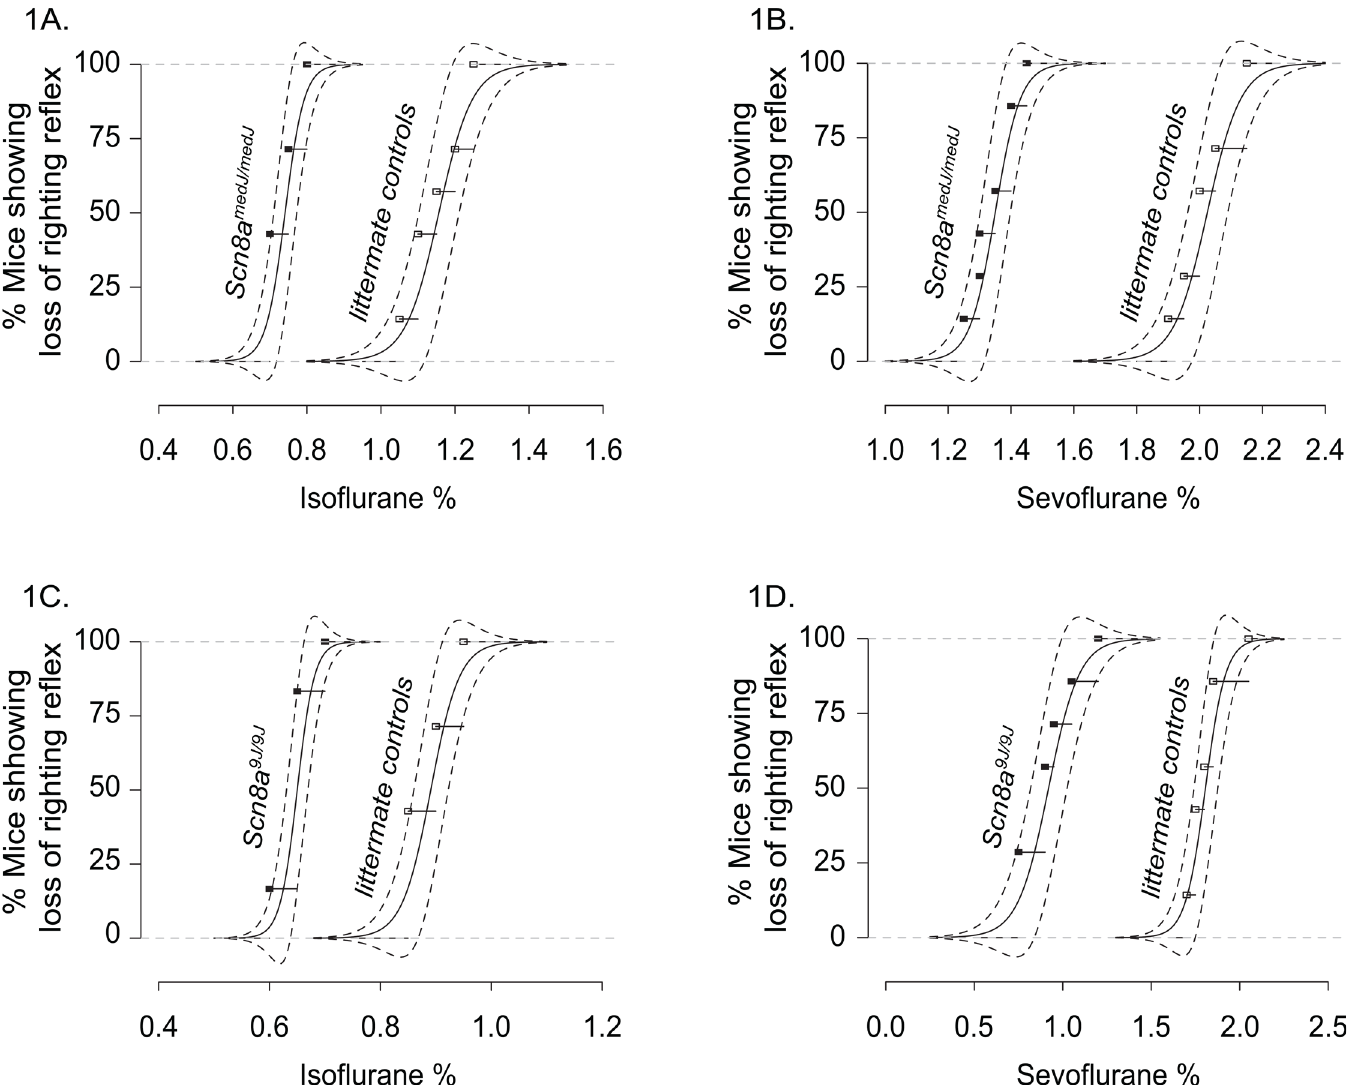
Fig 1. Increased anesthetic sensitivity in mice with Scn8a medJ and Scn8a 9J mutations. Best-fit dose response curves along with 95% confidence band (dashed lines) show the behavioral response (loss of righting reflex) of Scn8a medJ/medJ (A and B) and Scn8a 9J/9J (C and D) mice and their respective littermate control groups to increasing concentration of isoflurane and sevoflurane anesthesia. Seven mice were used for each group. Loss of righting reflex was used as a surrogate for unconsciousness. Filled (mutant mice) and open (littermate controls) squares represents the percentage of mice that lost the righting reflex in response to isoflurane (A and C) and sevoflurane (B and D) . Data were combined from two trials for each anesthetic and for each mouse. EC 50% shows a statistically significant (p < 0.0001) leftward shift in the mutant mice, indicating hypersensitivity to anesthesia.